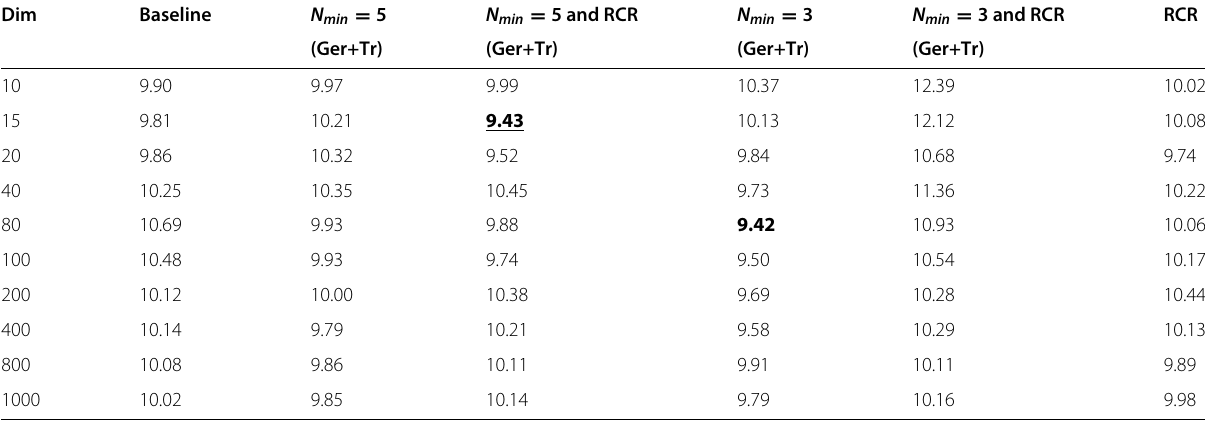
Table 8 Regression performance of the ml-MRMR Methods for the German database when the minimum occurrence threshold N min is sets 3 and 5. Results are shown both when the RCR algorithm is used and not used. In the underlined bold case, improvement is significant compared to the baseline system. Result with Gemaps feature set was: 10.14